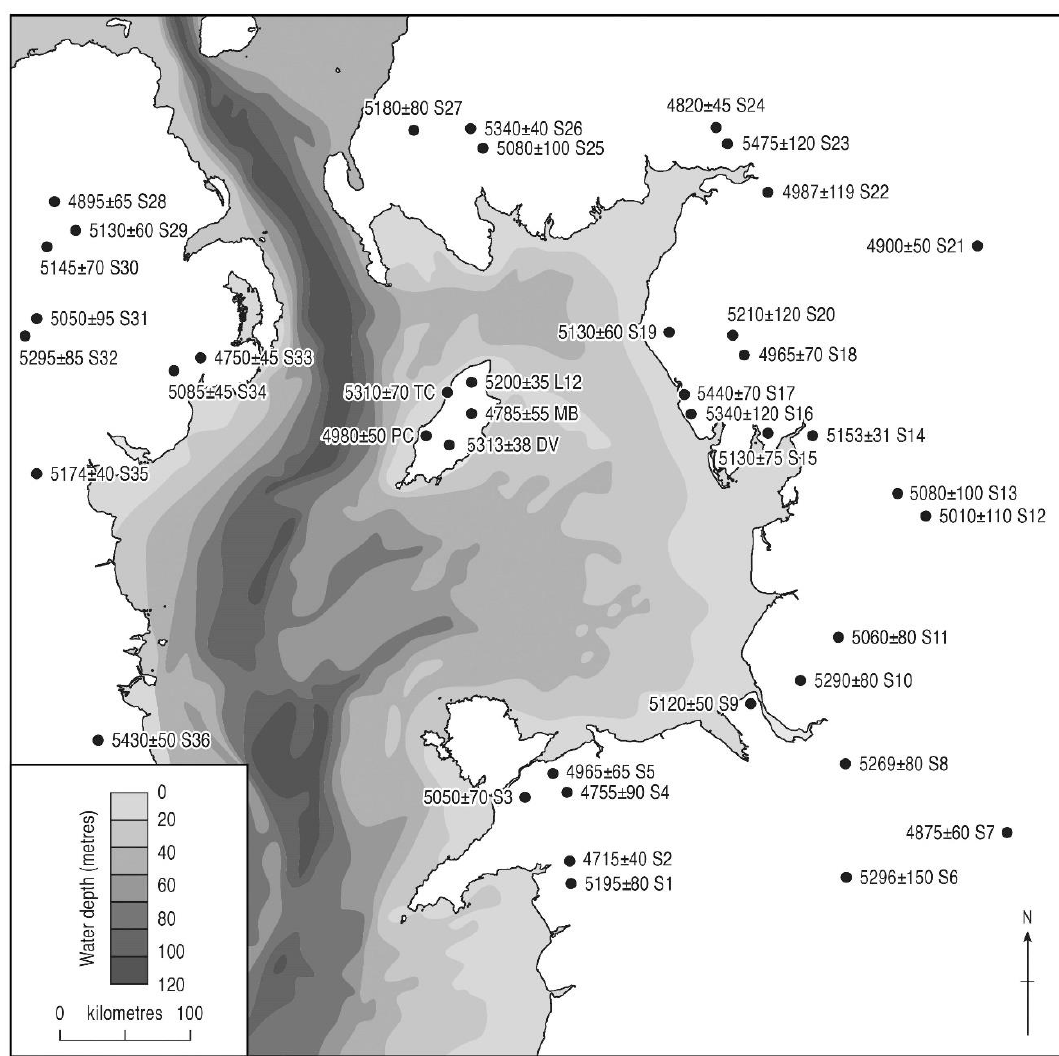
Figure 17. Radiocarbon ages for the Ulmus Decline in the northern Irish Sea region. For sources and date calibration ranges see Supplementary File S1.